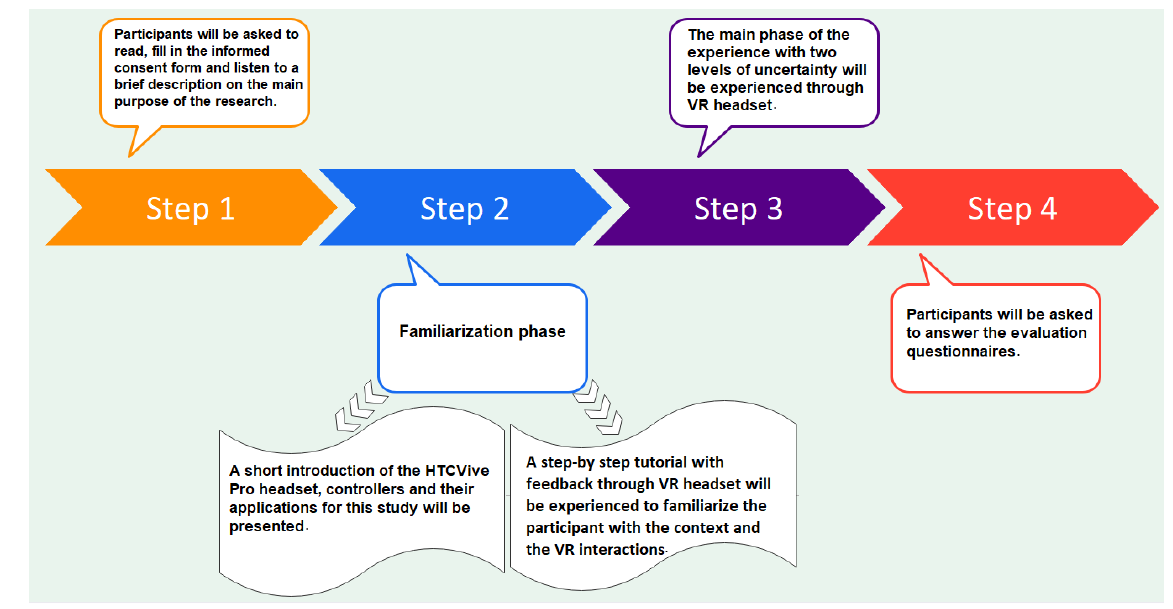
Figure 8. The steps that the participant